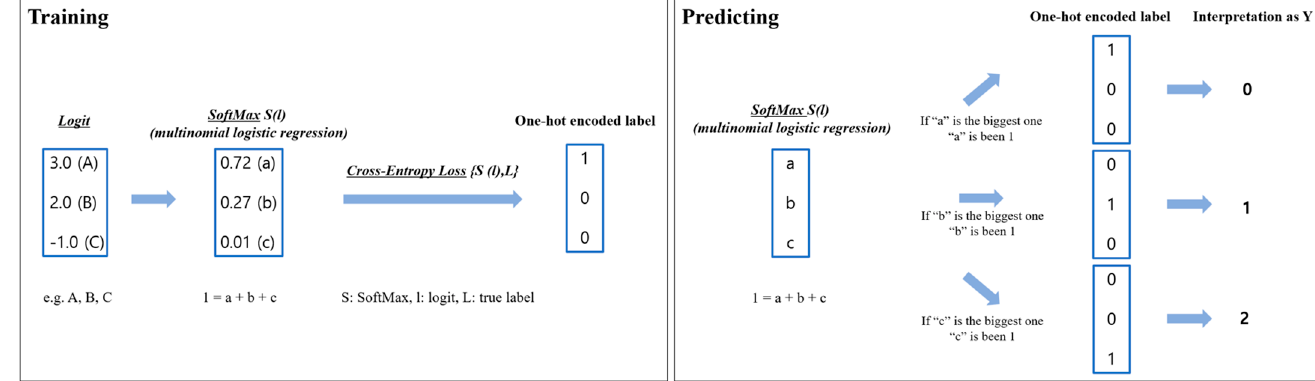
Figure 1. Schematic diagram of our model including training and predicting.